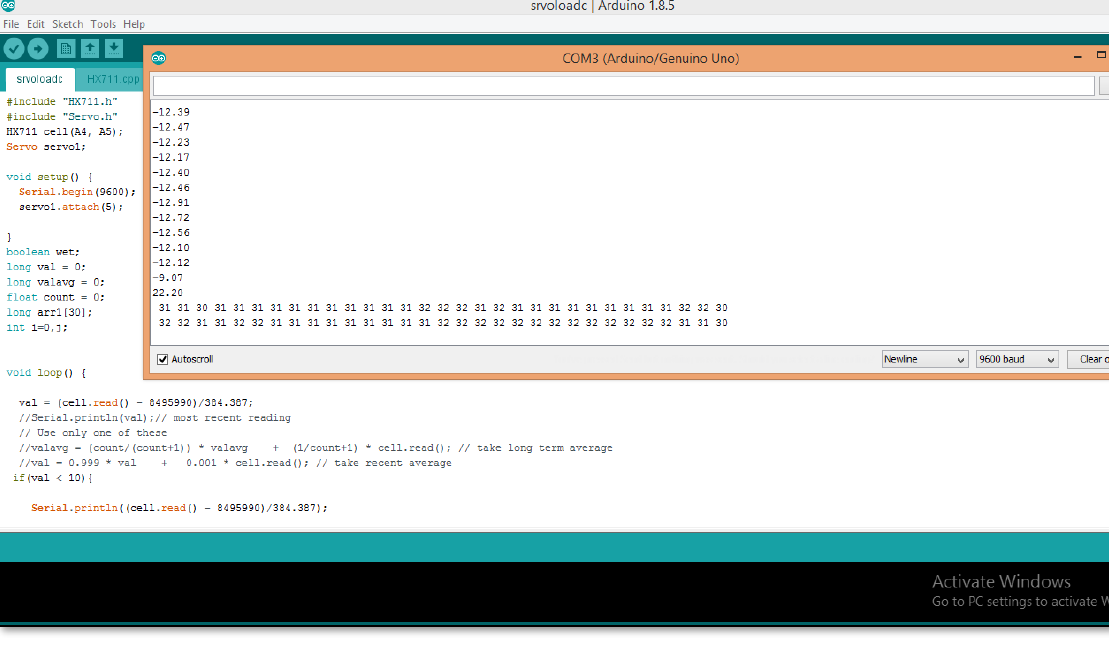
Figure 17. Monitoring system output (in this case, the bin is full, the output is complete). Figure 18. Monitoring system output (in this case, the bin is empty, the output is empty). A fuzzy inference system with GA is integrated for image classification. This classi- fication distinguishes between recyclable and non-recyclable garbage waste. Figure 19 illustrates the different kinds of waste that have been appropriately marked and recog- nized by the classifier.